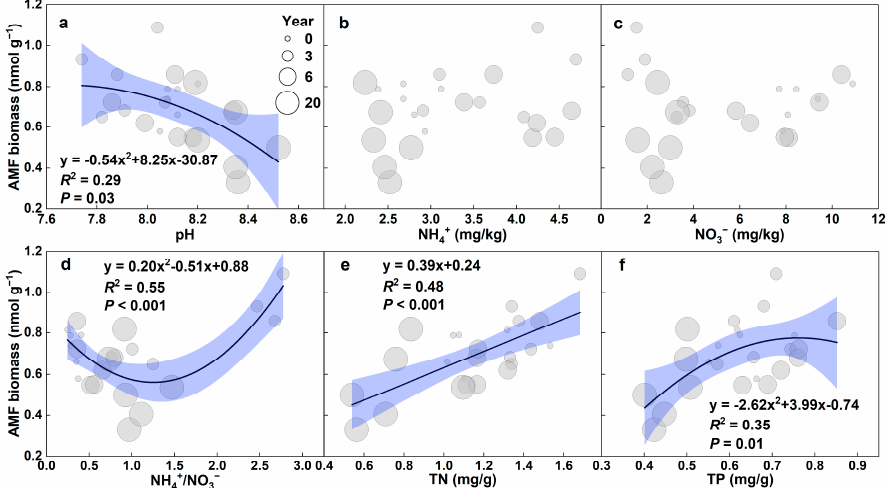
Figure 9. Relationships of arbuscular mycorrhizal fungi biomass (AMF biomass, nmol·g − 1 ) with soil properties (pH, ( a ); NH 4+ , ( b ); NO 3 − , ( c ); NH 4+ /NO 3 − , ( d ); TN, ( e ); TP, ( f )). See abbreviations in Table 2. Table 2. Relative contributions (increase in mean squared error (MSE), %) of soil properties to PLFAs based on Random Forest analysis. NH 4+ : soil ammonium-nitrogen content; NO 3 − : nitrate- nitrogen content; NH 4+ /NO 3 − : the ratio of NH 4+ to NO 3 − ; TN: total nitrogen content; TP: total phosphorus